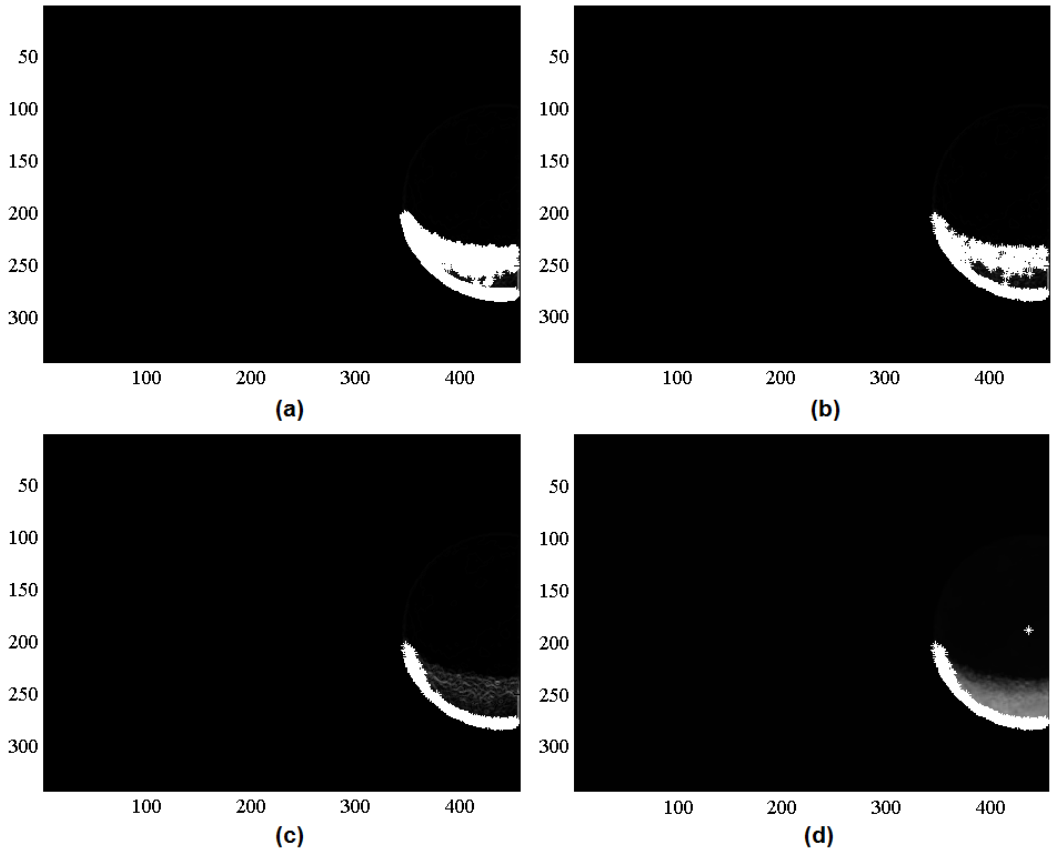
Figure 13. Example 2: Image processing phases (data in pixel). ( a ) 1500 highest derivatives; ( b ) 21 × 21 box approach removed 911 outliers; ( c ) RANSAC removed 229 outliers using = 4 ; ( d ) Body center inside image. Row center = 189.0829, Column 100 tests and d min center = 437.5094, Radius = 89.0182 (worst residual =